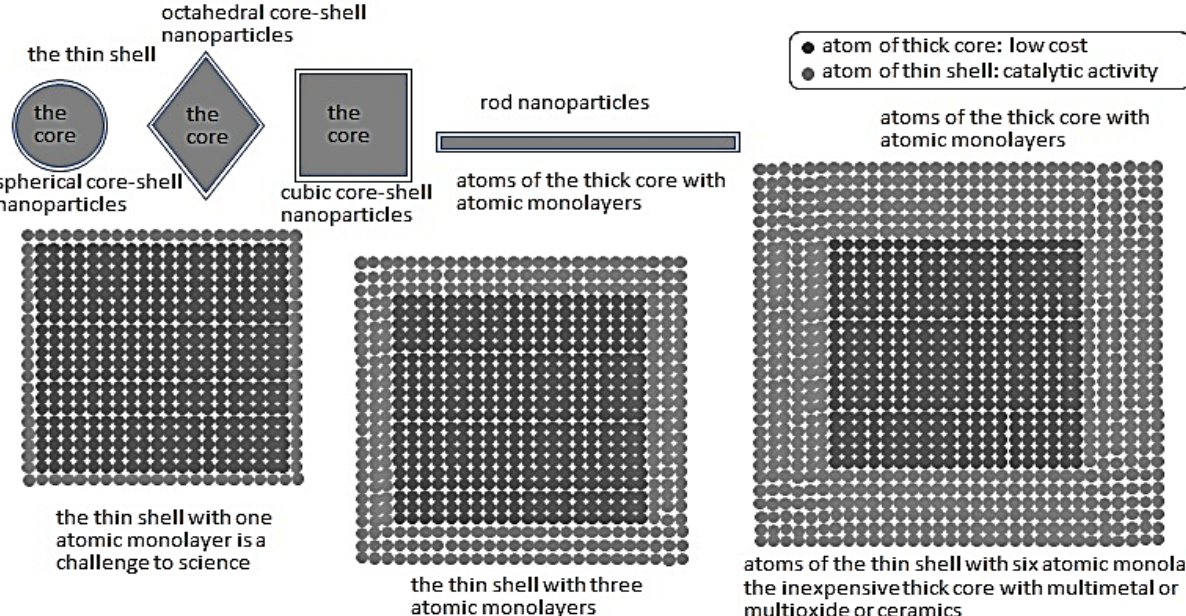
Figure 10. The typical models of the cubic Pt-Pd core-shell nanoparticles with the thin Pd shells with several Pd atomic monolayers on the thick cores. This is also a challenge to science. The thin shells of Pt or Pd on the thick metal, bimetal, multimetal, alloy and oxide cores can be realized by modified polyol methods using agents added during the designed process